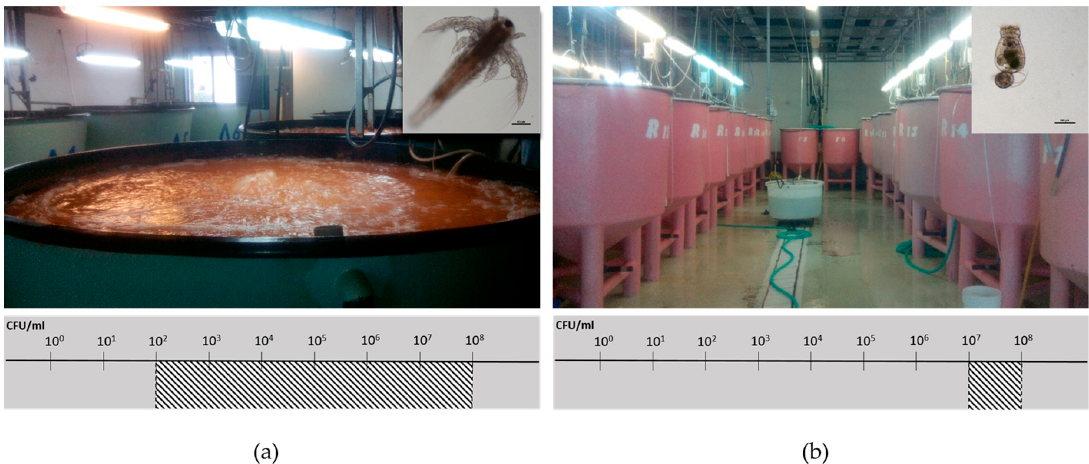
Figure 2. Facilities for live feed production from a commercial fish farm unit. ( a ) Artemia salina in culture tanks with vigorous aeration, where the native presumptive Vibrio load is regularly estimated between 10 7 and 10 8 cells per mL; ( b ) Brachionus plicatilis culture tanks, where the native presumptive Vibrio load is regularly between 10 2 and 10 8 cells per mL [103].